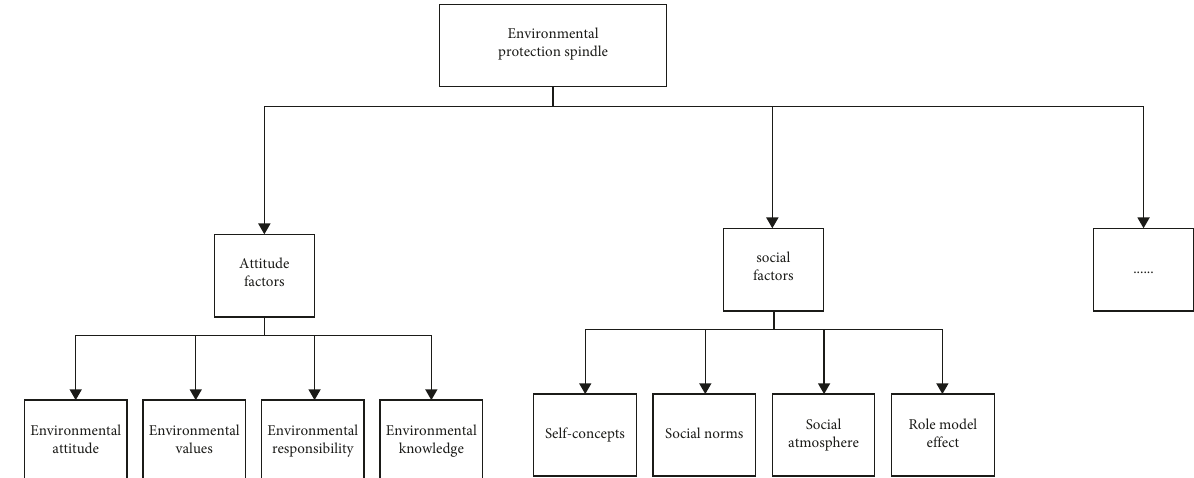
Figure 3: Theoretical model of factors that may influence the environmental protection behavior of tourist.